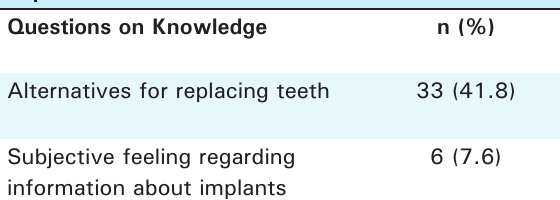
Table 7. Correct response on Knowledge of Dental